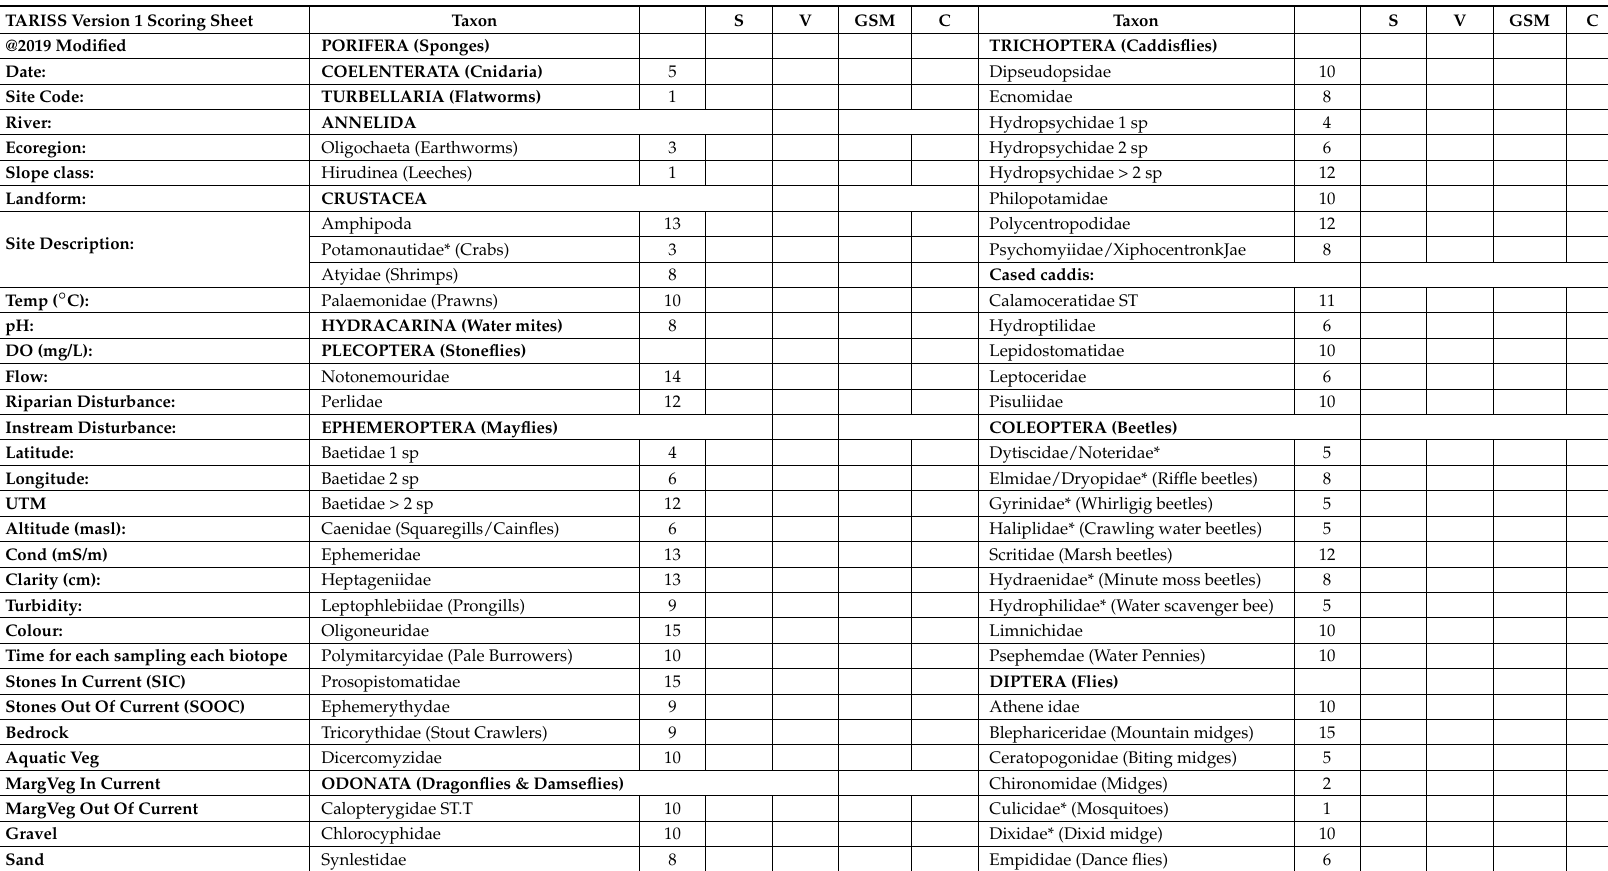
Table A1. TARISS version 1 scoring sheet showing a list of macroinvertebrate taxa and their respective sensitivity weightings. Columns adjacent to the sensitivity weightings indicate the biotopes at which collected families are to be recorded (S = Stones, V = Vegetation, GSM = Gravel sand mud and C =